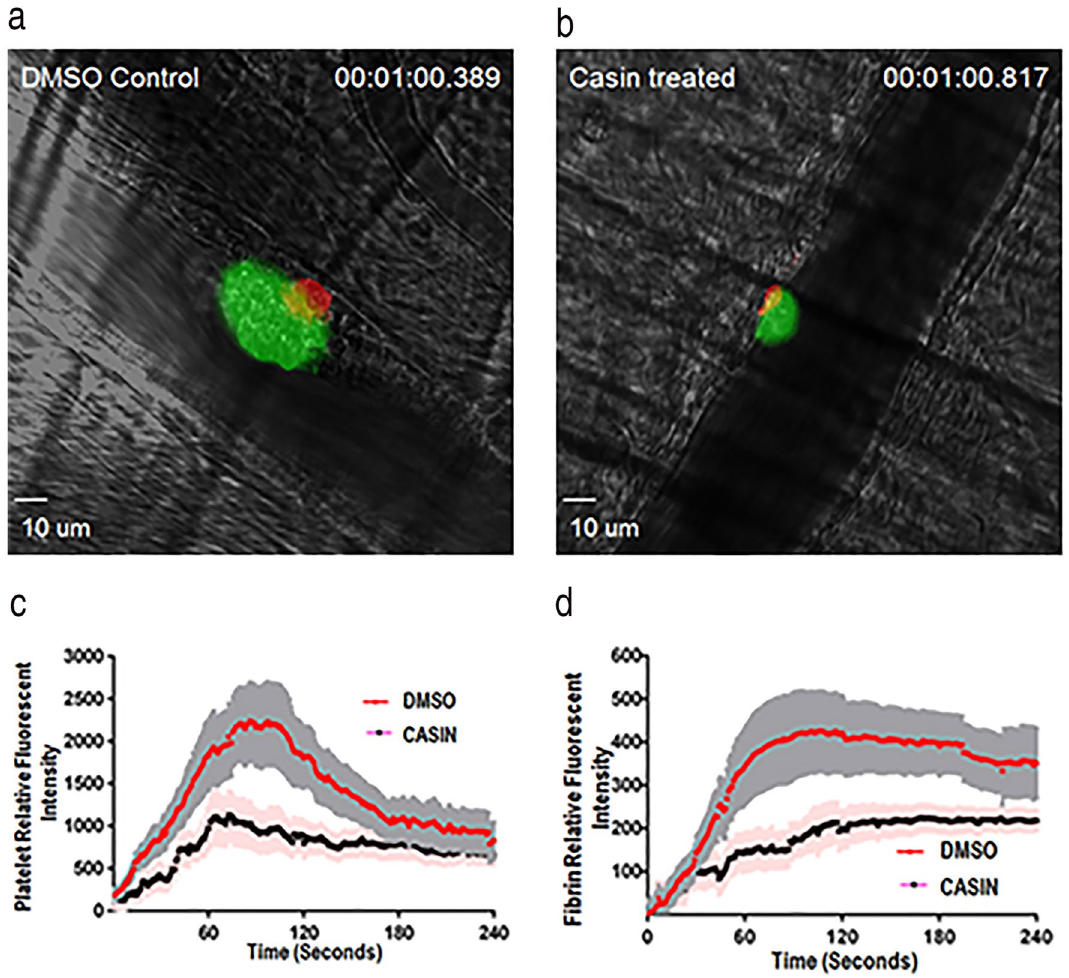
Figure 6. CASIN diminished in vivo thrombus formation. ( a ) Thrombus formation in DMSO (left) or CASIN (right) treated WT mice. CASIN (3.0 mg/kg) or equal volume of DMSO was intravenously injected into mice 10 min prior to induction of thrombus formation by laser-induced injury in the murine cremaster muscle arterioles. Multiple independent thrombi (5- 8 thrombi in each mouse, 3 mice in each group) were induced in the arterioles (30–50 μm diameter) in each mouse by a laser ablation system. Images of thrombus formation were acquired in real-time and analyzed as detailed in methods section. Treated mice, compared to control mice, exhibited a notable decrease in accumulation of platelets (green) and fibrin in the thrombi (red). ( b ) Measurement of fluorescent intensity of platelet accumulation (left) and fibrin deposition (right) at the site of injury in the WT mice in the cremaster arterial thrombosis. The kinetic curves represent the mean fluorescence intensity and the shaded regions are representative of the standard error (SEM). A total of 24 thrombi in DMSO treated mice and 16 thrombi in CASIN treated mice were compared. CASIN treated mice, compared to control mice, exhibited a notable decrease in accumulation of platelets in the